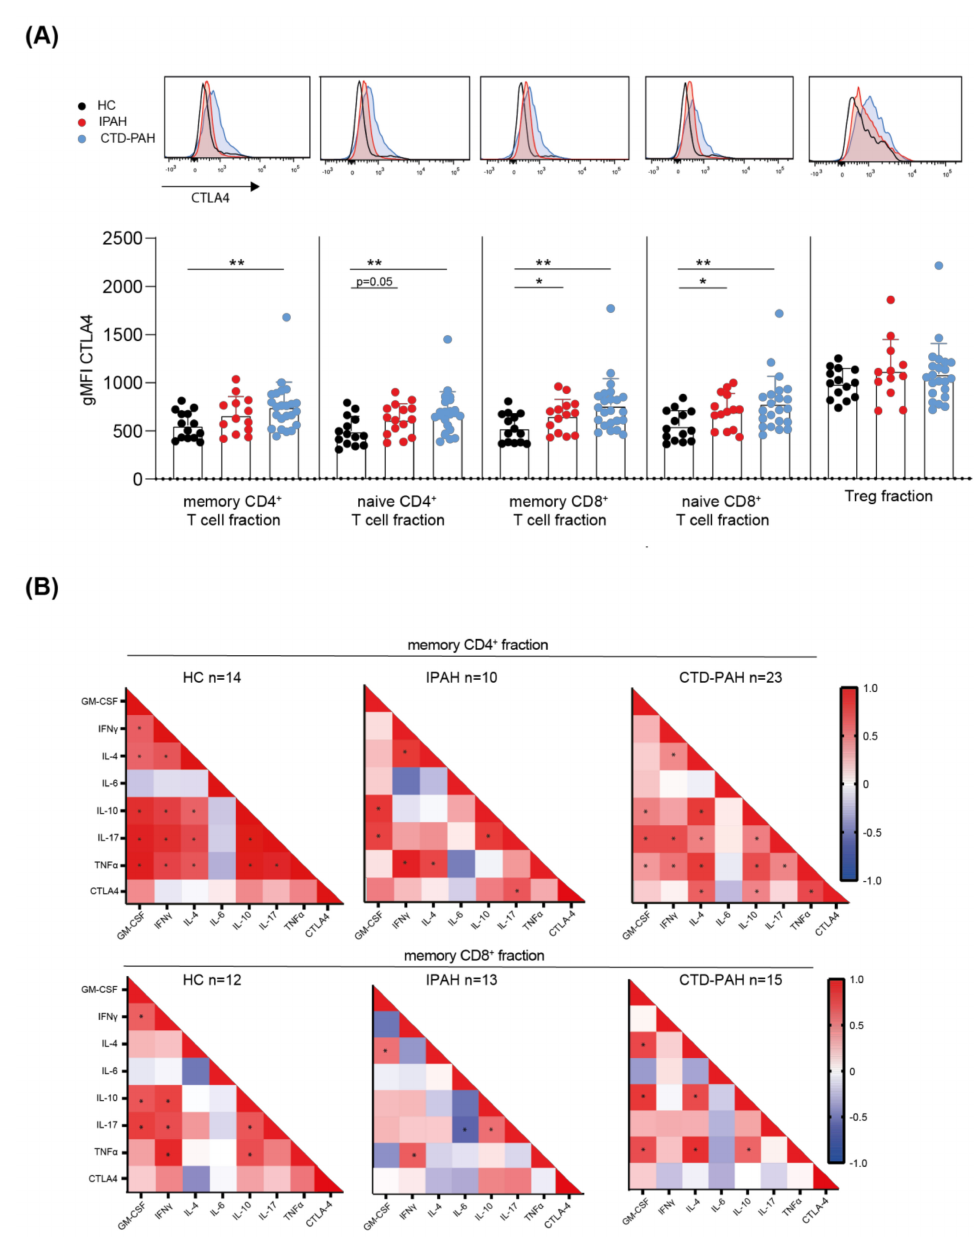
Figure 2. T cells of PAH patients show increased CTLA4 expression. ( A ) Quantification of intracellular CTLA4 expression, as determined by flow cytometry, in the indicated CD4 + and CD8 + T cells fractions of HCs, IPAH and CTD-PAH patients, shown as histogram overlays ( top ) and quantification ( bottom ). Samples with <500 events in parent gate were excluded (HC n = 14, IPAH n = 12–15 and CTD-PAH n = 22–23). ( B ) Associated correlation matrixes for cytokine-positive CD4 + and CD8 + T cells in HCs and patients with IPAH and CTD-PAH. Numbers of patients included are indicated above the correlation matrices. Correlation coefficient was calculated using nonparametric Spearman correlation. Results are presented as mean + standard deviation and symbols represent values of individual patients or HCs. Mann–Whitney U test was used for statistical analysis, * p < 0.05, ** p < 0.01. gMFI = geometric mean fluorescence